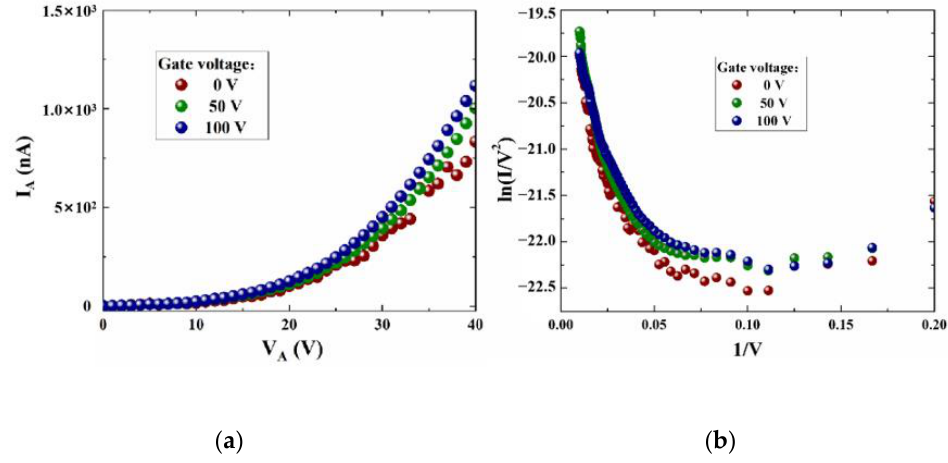
Figure 10. ( a ) I A versus V A at different gate voltages, ( b ) F-N fitting curve.